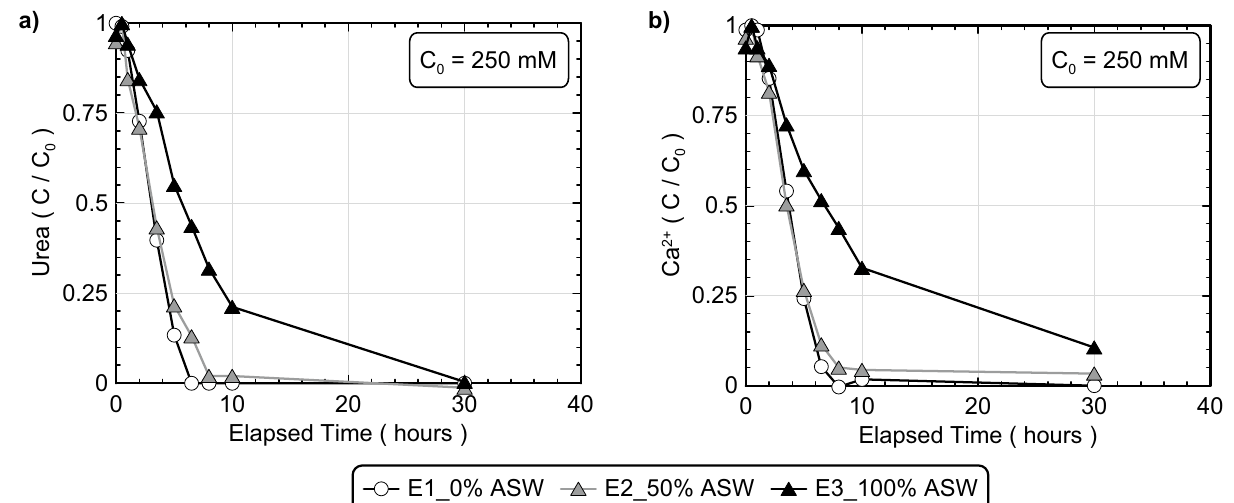
Figure 1. Normalized concentrations of ( a ) urea and ( b ) Ca 2+ in time for 0%, 50%, and 100% ASW experiments. All experiments included the addition of 250 mM urea, 250 mM Ca 2+ , S. pasteurii cells at 7.6 × 10 7 cells/mL, and varying ASW